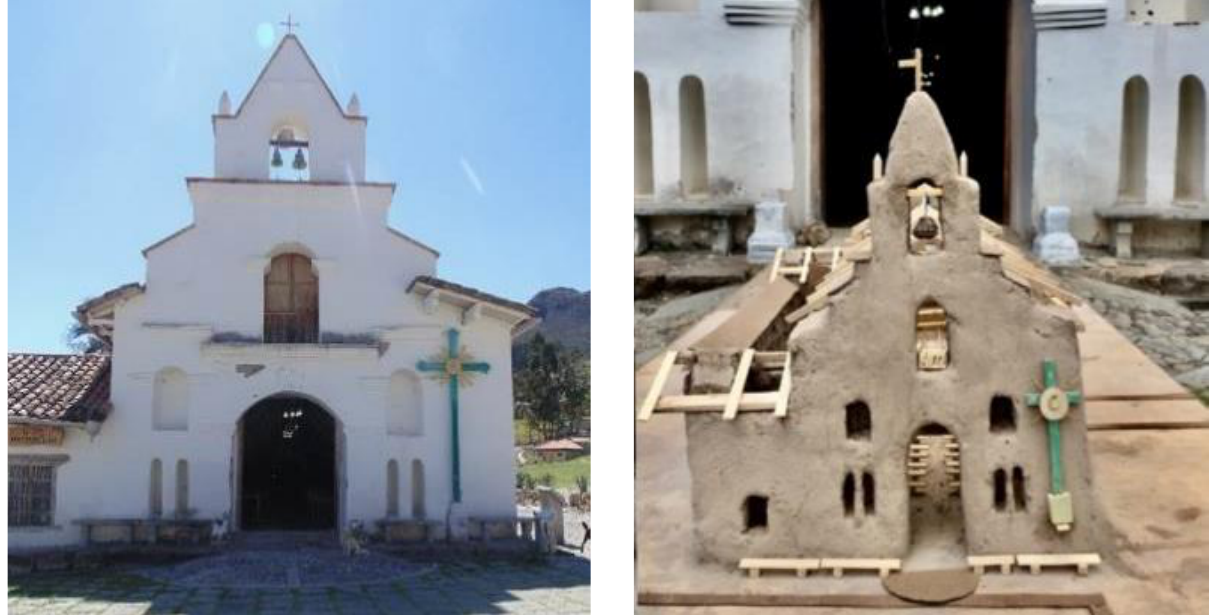
Figure 4. a) The community chapel. Source: Photographic Repository of the Ciudad Patrimonio Mundial project.